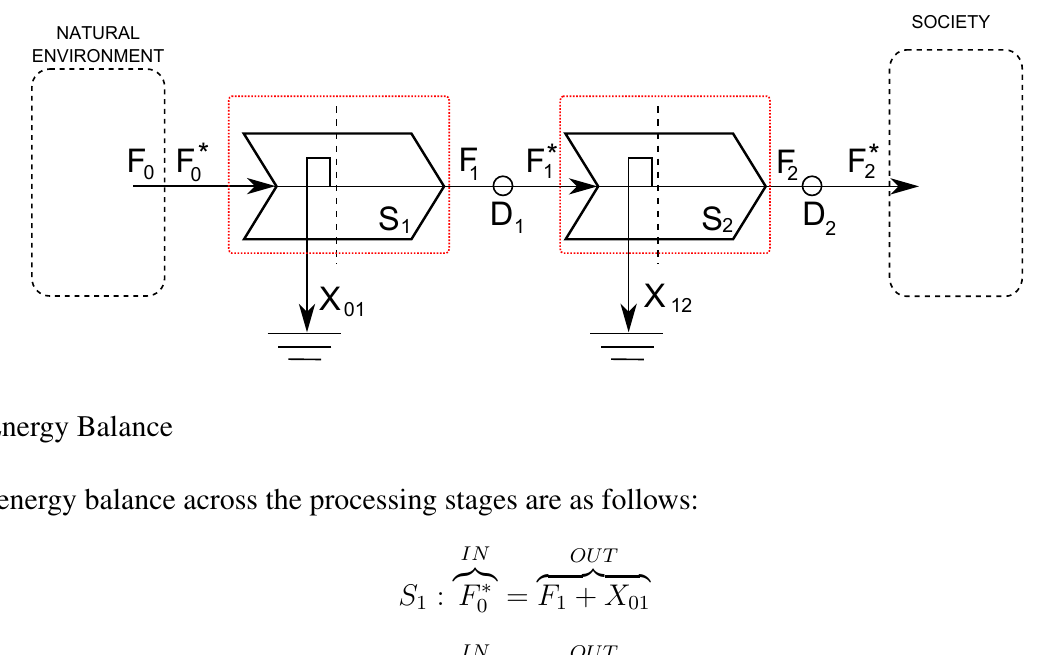
Figure 8. Energy production process with one pathway and two stages of only internal